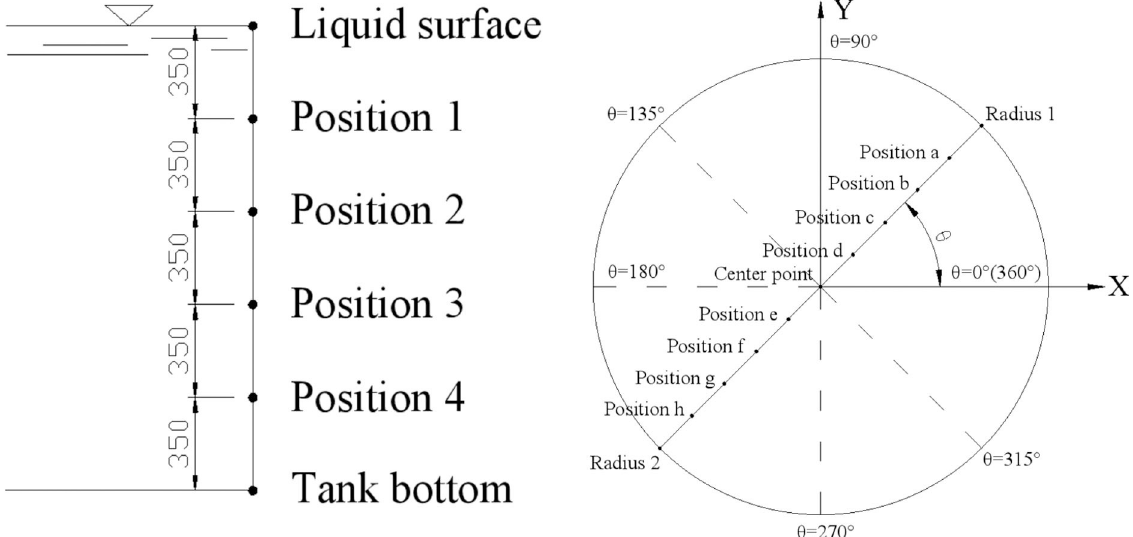
Fig 10. Diagram showing position of extraction points for A-50% condition. a)Points on the tank wall. b) Points in the circumferential and radial directions of the tank bottom.